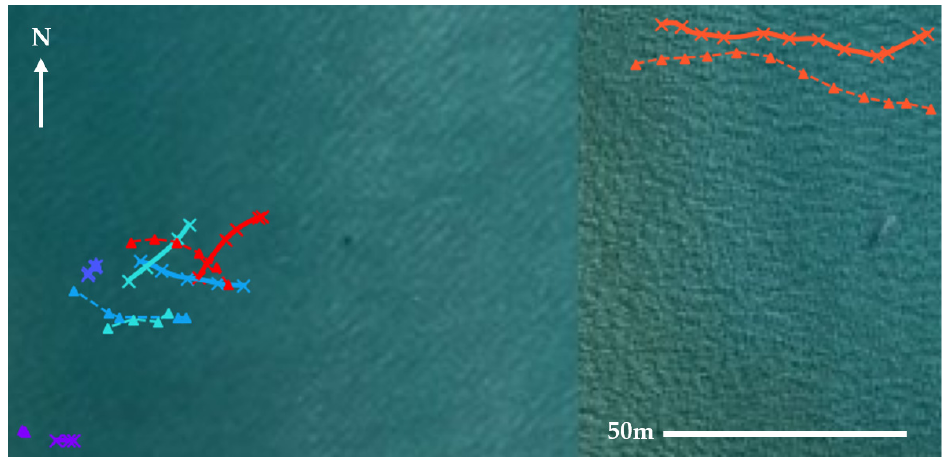
Figure 8. Comparison of WPTs with GPS surfer tracks in the nearshore region. - Δ - = GPS points; -×- = Gaussian-smoothed WPTs time synchronised with GPS points at 1 Hz. Table 2. GPS tracks compared with WPTs in the nearshore region.